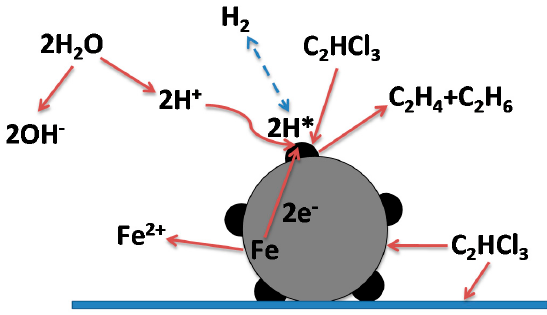
Figure 6. Schematic diagram of Pd/Fe galvanic cell process, the grey ball is an iron nanoparticle, the black balls are tiny palladium particles, and the horizontal bar represents silica wall. The standard reduction potential of Fe 2+ /Fe and Pd 2+ /Pd pair is − 0.447 and 0.951 V respectively [23]. Degradation of trichloroethylene is greater than production of ethylene plus ethane in all cases.